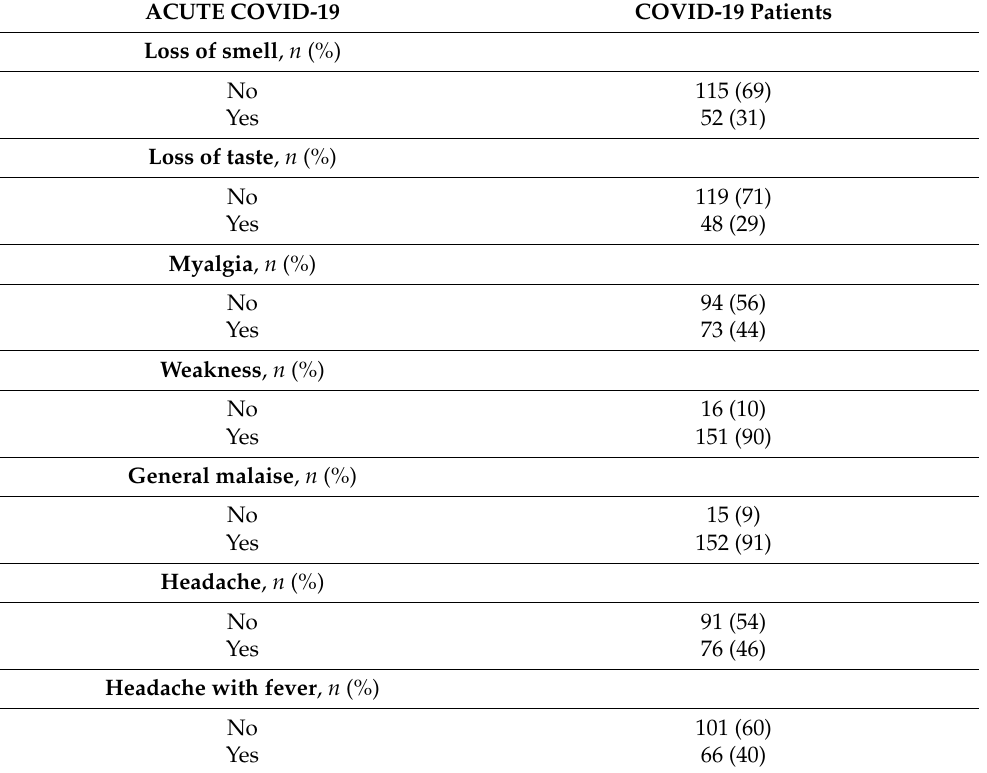
Table 2. Neurological manifestations in acute COVID-19.